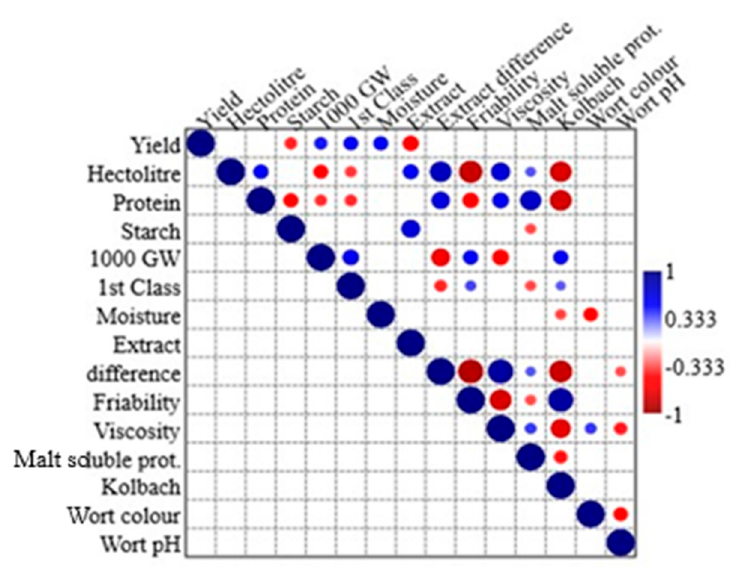
Figure 2. Correlation matrix of agronomic and quality traits for winter barley cultivars observed through four growing seasons (2016–2019) (Note to correlation key and the scale reads: positive—blue, negative—red; smaller circle—lesser significance; bigger circle—greater significance; non-sig- nificant values are not shown (blank square)).